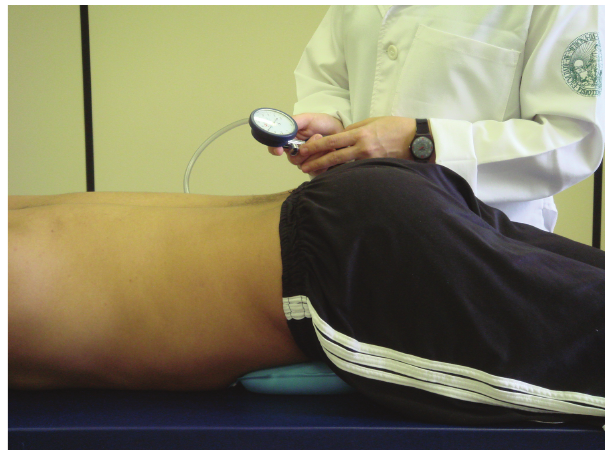
Figure 1 - The test of the abdominal drawing in action in a prone position, monitoring the contraction of TrA with pressure